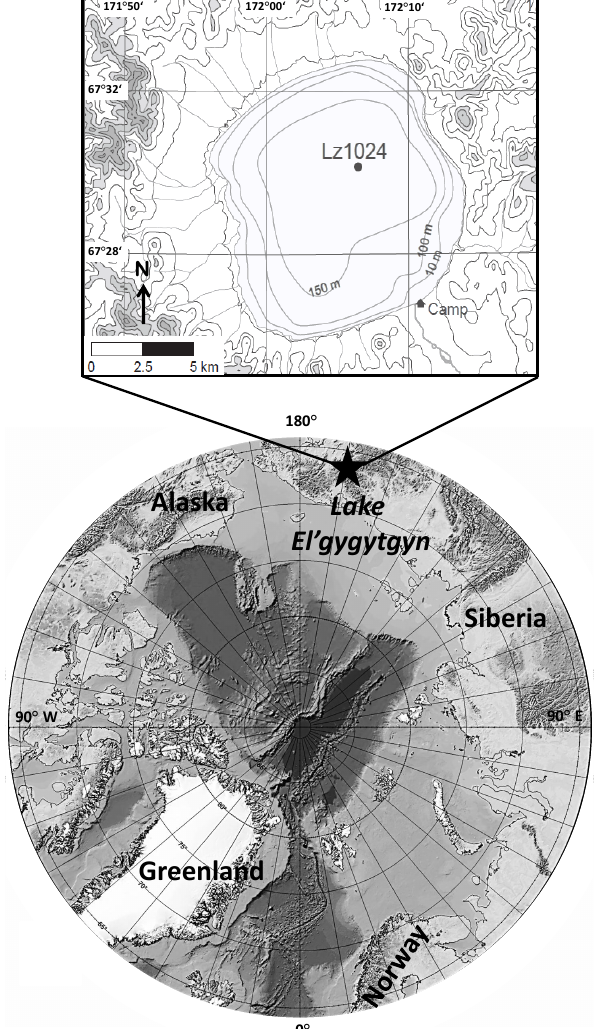
Fig. 1. Map of the Arctic region showing the location of Lake El’gygytgyn. Details of the catchment and coring site are shown in the inset (modified from Nolan and Brigham-Grette,